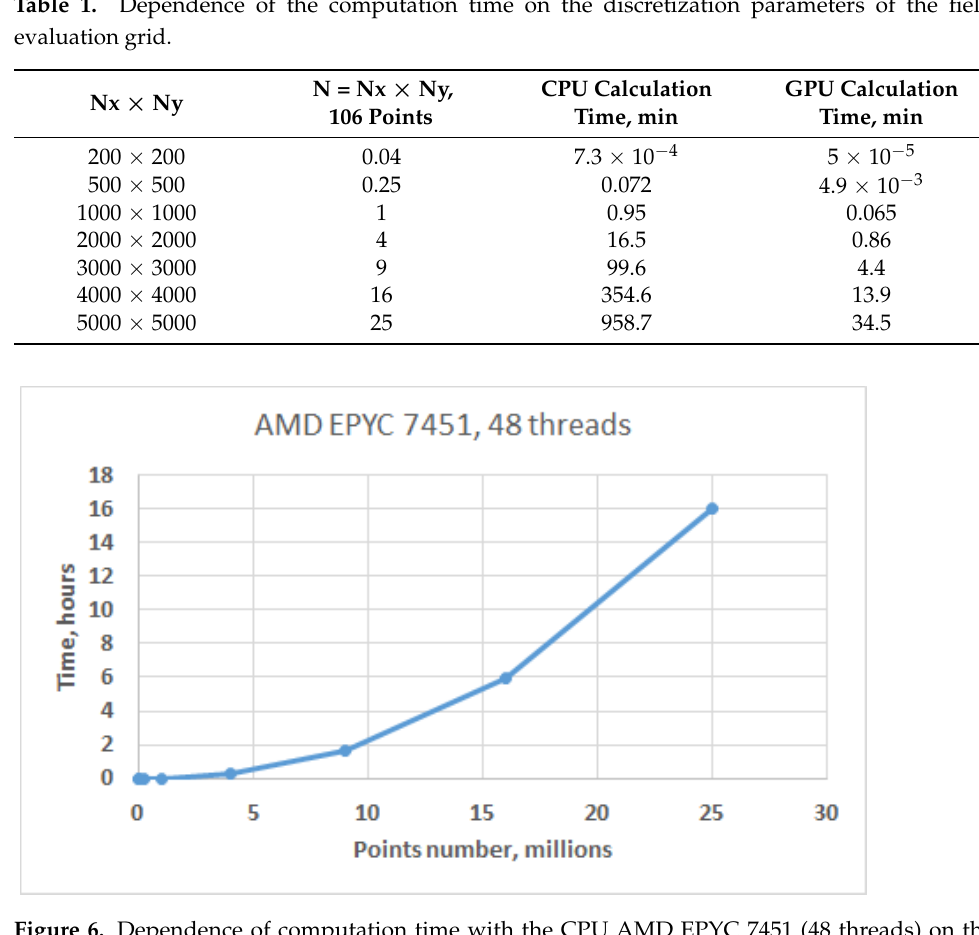
Figure 6. Dependence of computation time with the CPU AMD EPYC 7451 (48 threads) on the number of field evaluation points.